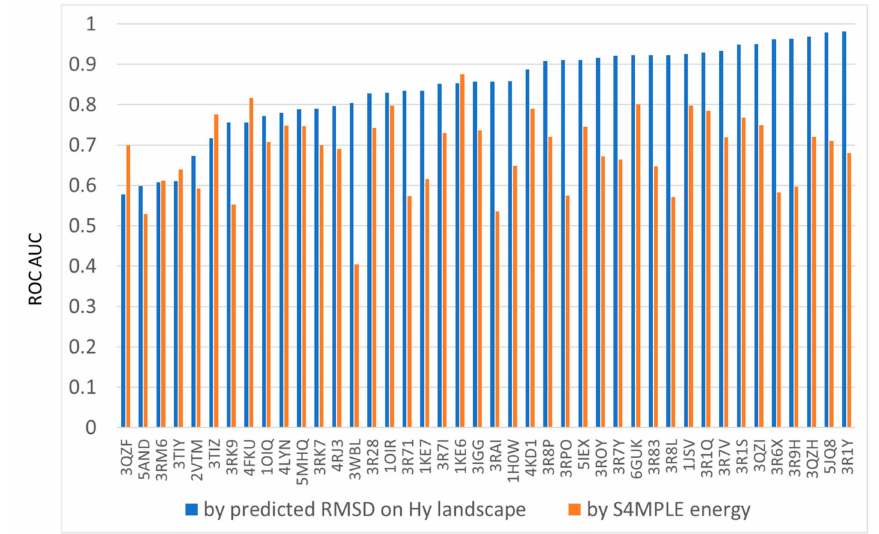
Figure 10. Comparative ROC AUC values obtained upon prioritizing the native-like poses of external ligands according to (in blue) RMSD values predicted by the Hy-based RMSD landscape versus (in orange) S4MPLE energy